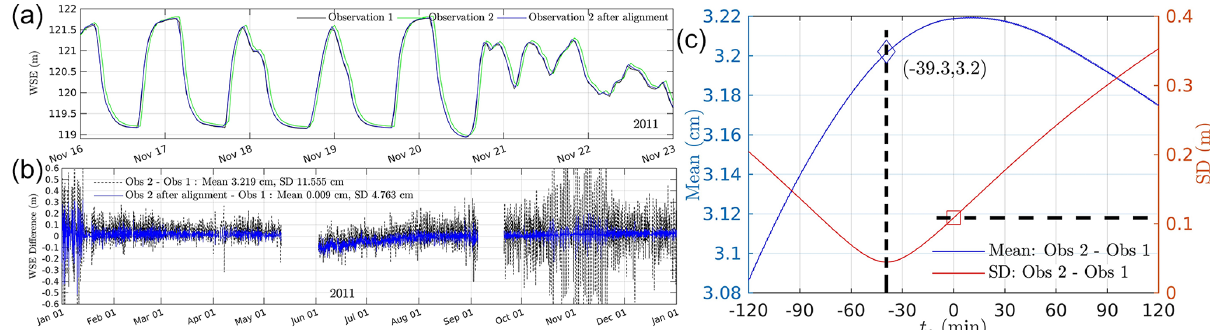
Figure A7. A comparison of WSE at 100B from observation 1, observation 2, and observation 2 after alignment (a) , the differences in WSE between observation 1 and observation 2 and that between observation 1 and observation 2 after alignment (b) , and the mean and standard deviation between observation 1 and observation 2 with a time shift t s (c)